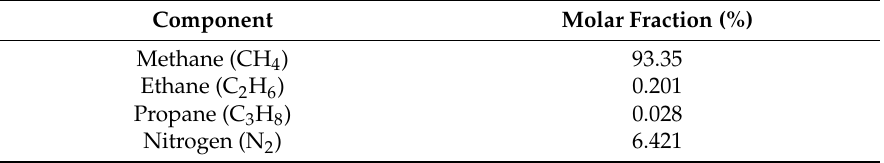
Table 3. Natural gas composition based on molar